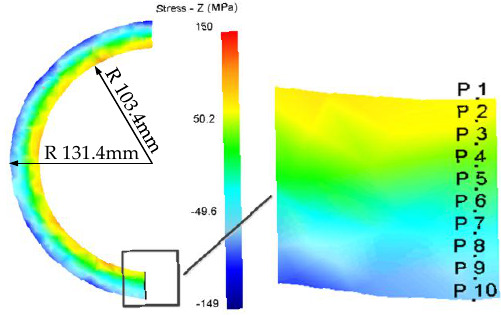
Figure 7. Ring-rolling residual stress from air-cooling.